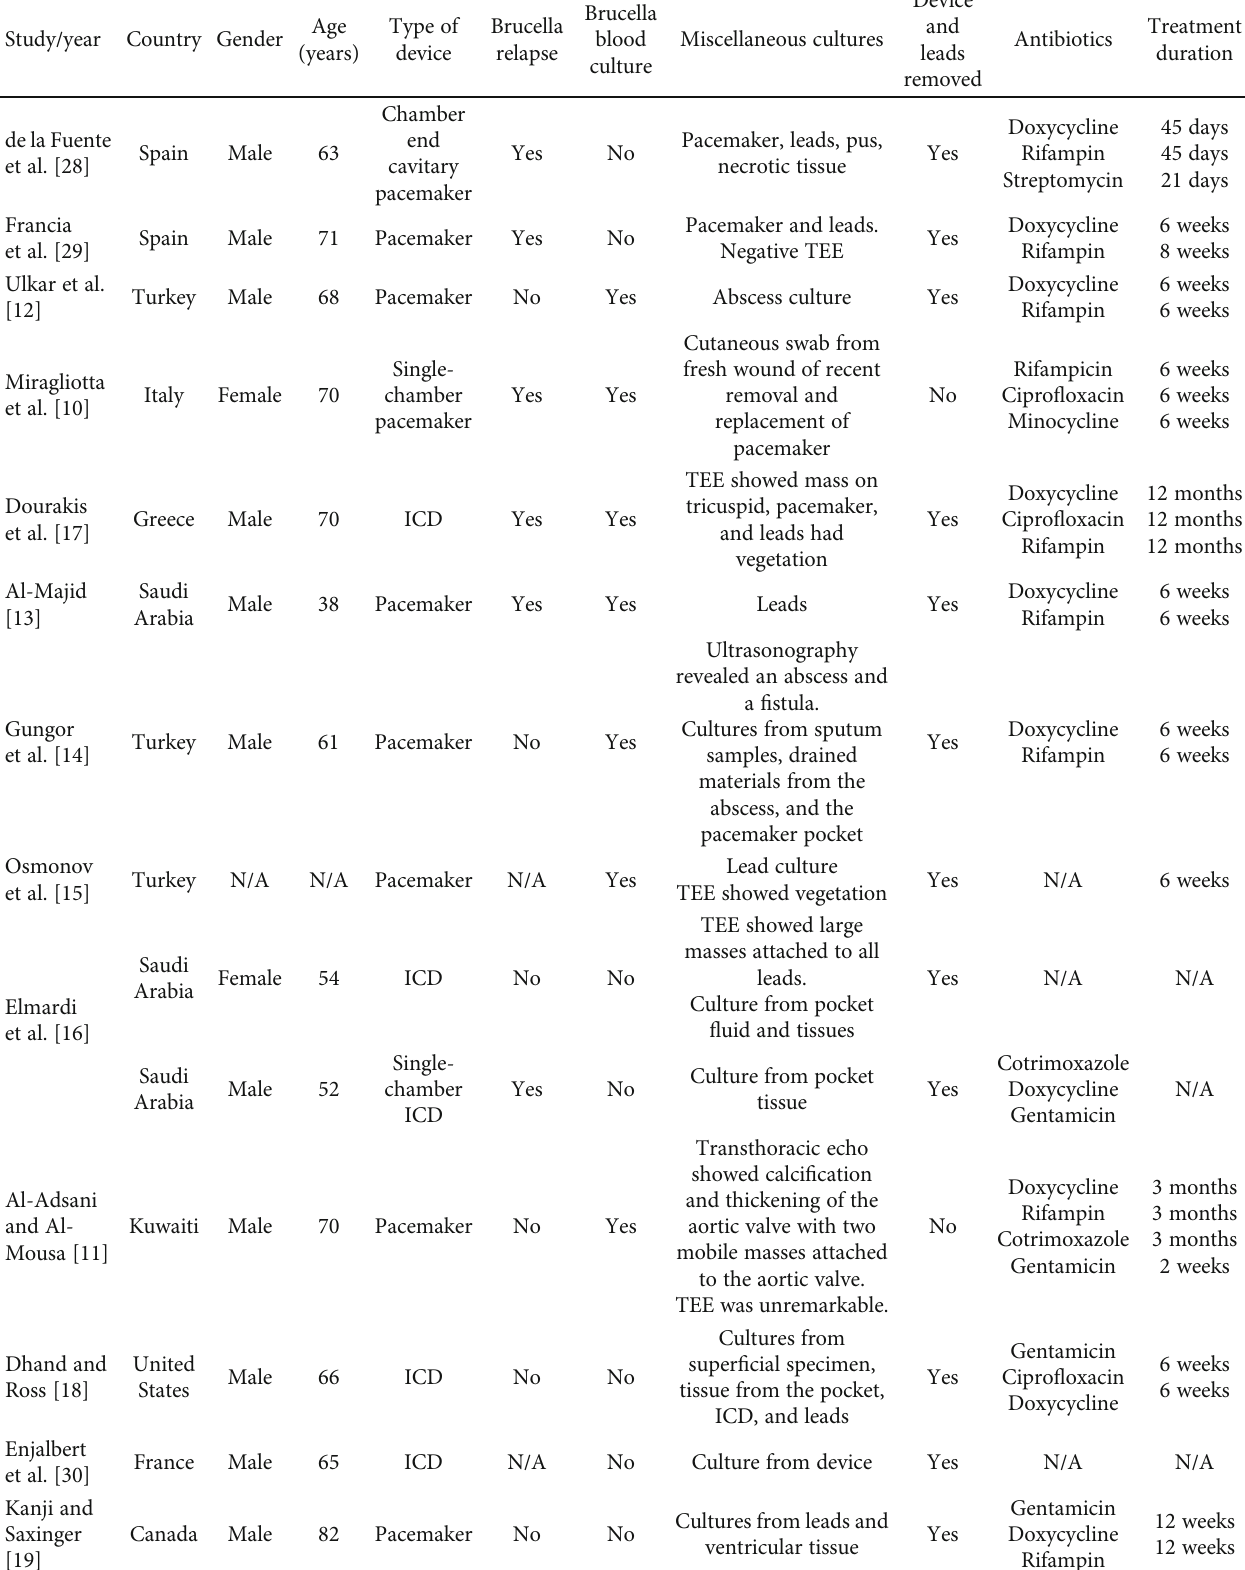
Table 1: Case reports of brucellosis involving pacemakers and cardiac